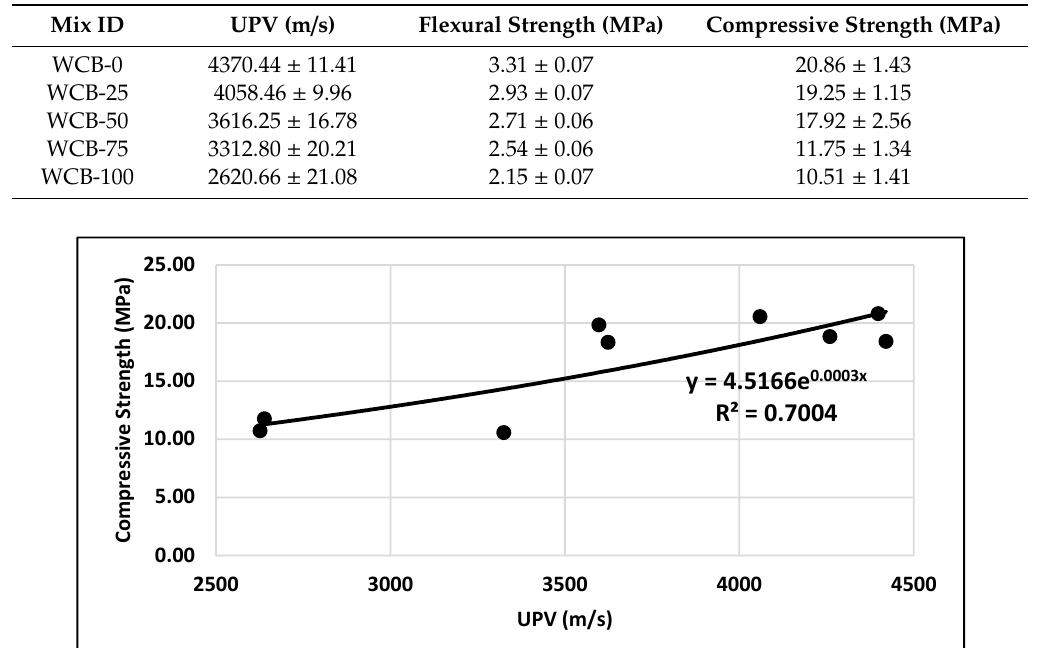
Table 7. The standard deviation of destructive and non-destructive testing.